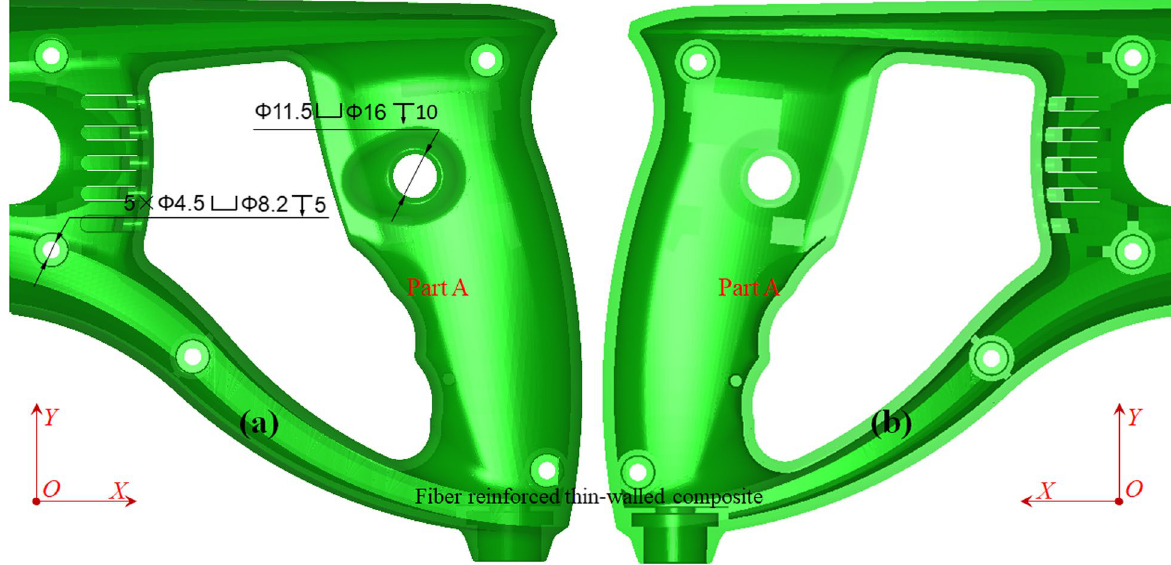
Fig. 7 Heavy-duty functional ergonomic half (Part A) handle: a main/front view and b back